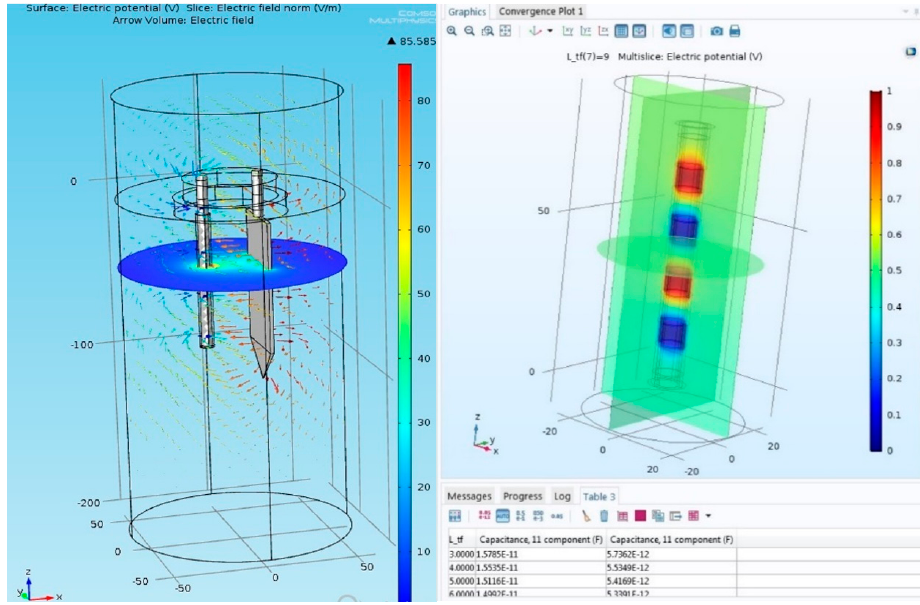
Figure 10. Simulation of the electric field and capacitance computing using COMSOL